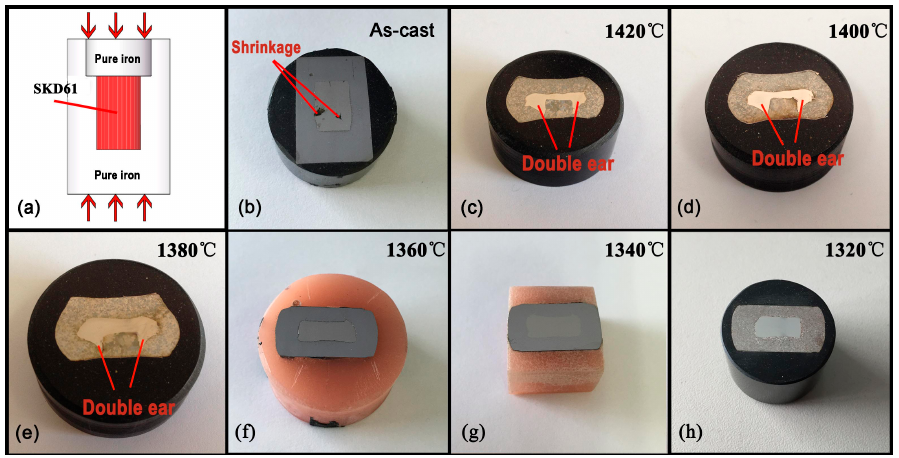
Figure 4. Macrostructures of the specimens (in longitudinal-section) under different experimental conditions in this study. ( a ) Schematic diagram of specimen, the red arrows are the deformation direction during the semi-solid compression tests; ( b ) as-cast state; ( c – h ) compressed specimens at different F L .